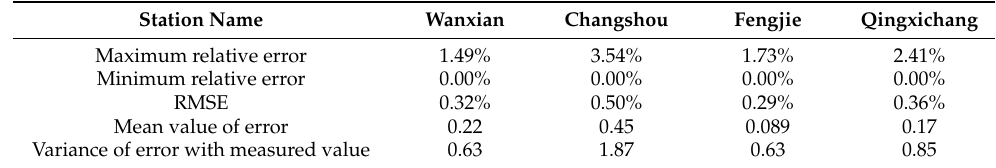
Table 1. Statistical comparison results for simulated and measured data at different hydrological